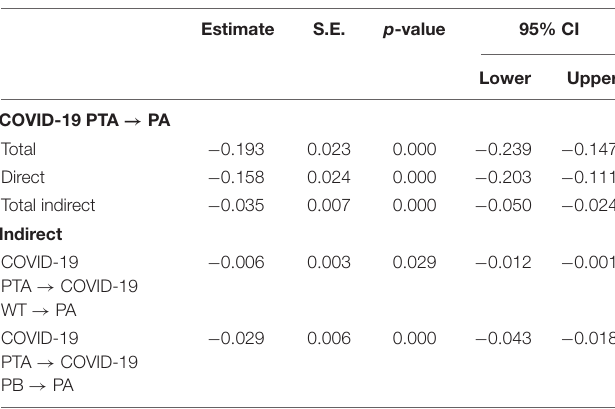
TABLE 5 | Results of mediating